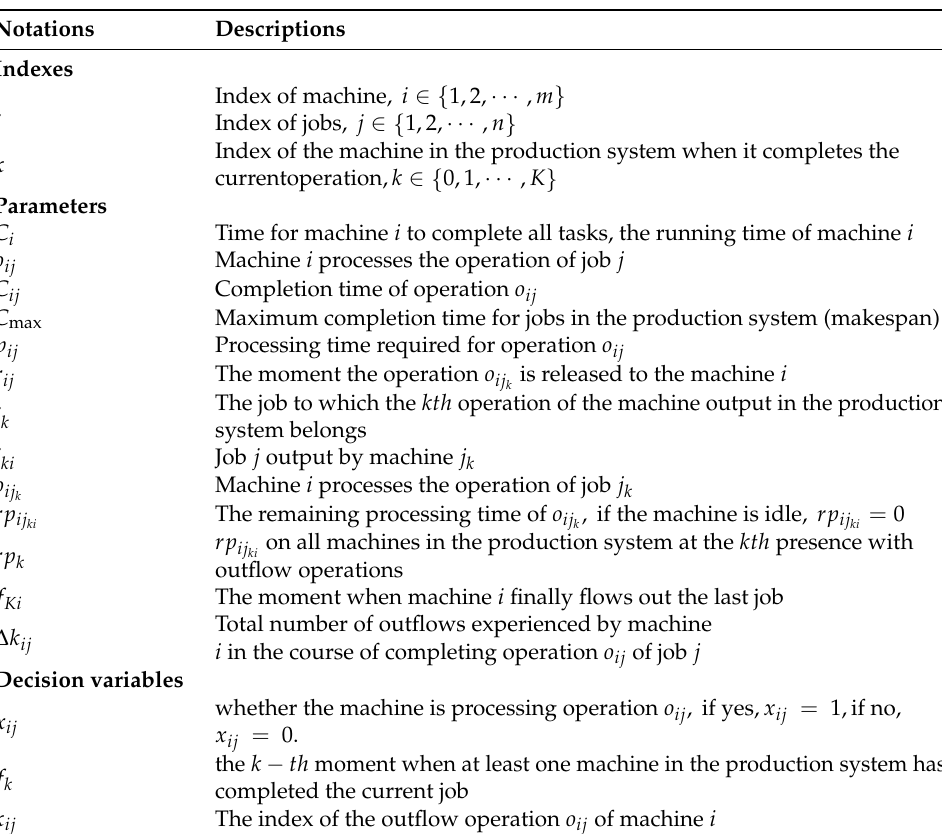
Table 2. Indexes and